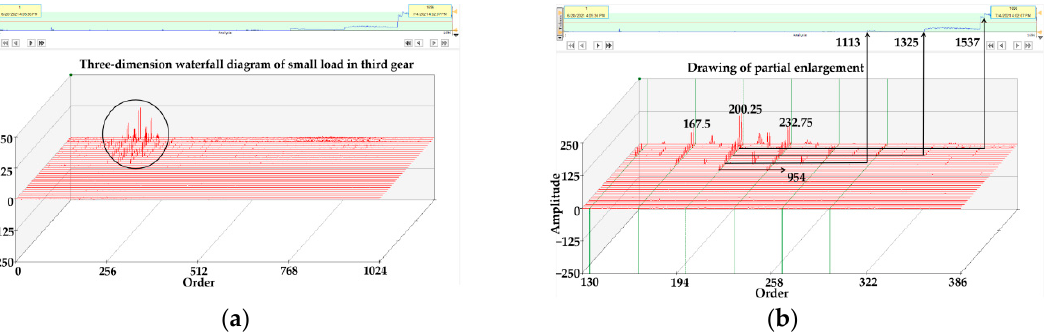
Figure 10. Three-dimension waterfall diagram ( a ) and drawing of partial enlargement ( b ) of difference spectrum of small load in third gear.